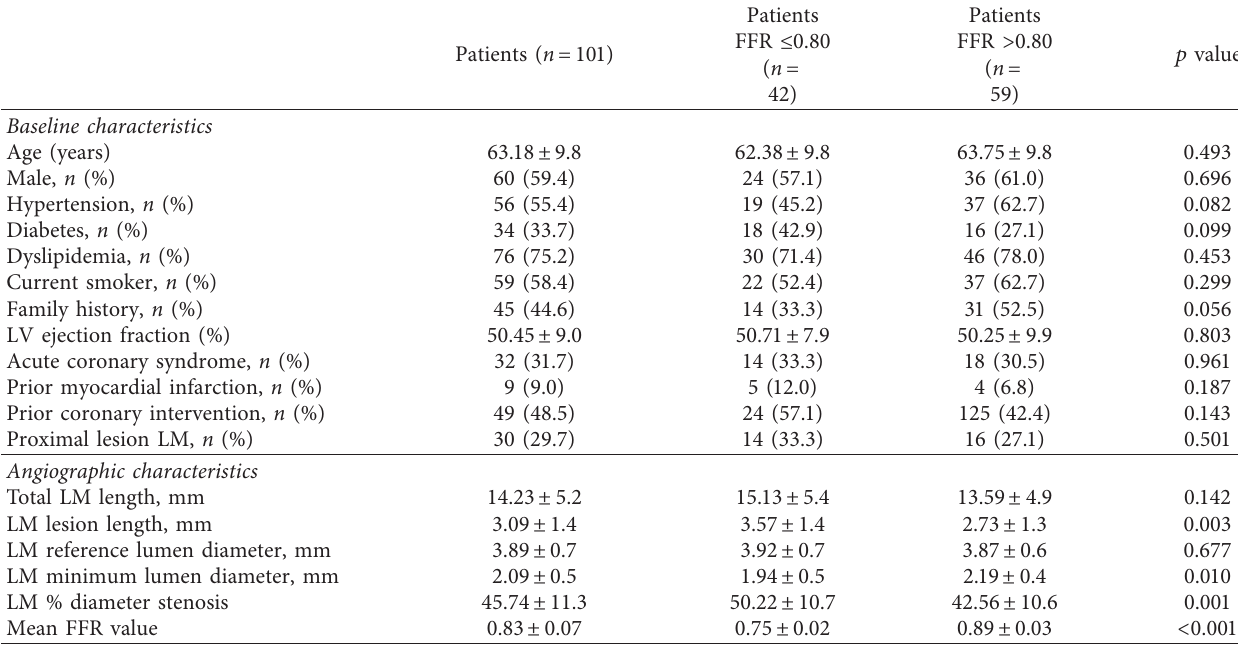
Table 1: Baseline clinical and angiographic characteristics of the study population.